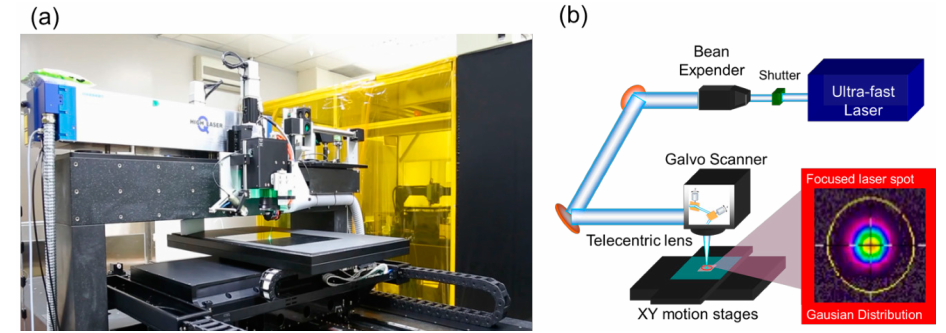
Figure 1. ( a ) The ultra-fast laser engraving system; ( b ) Gaussian beam profile of the ultra-fast laser.